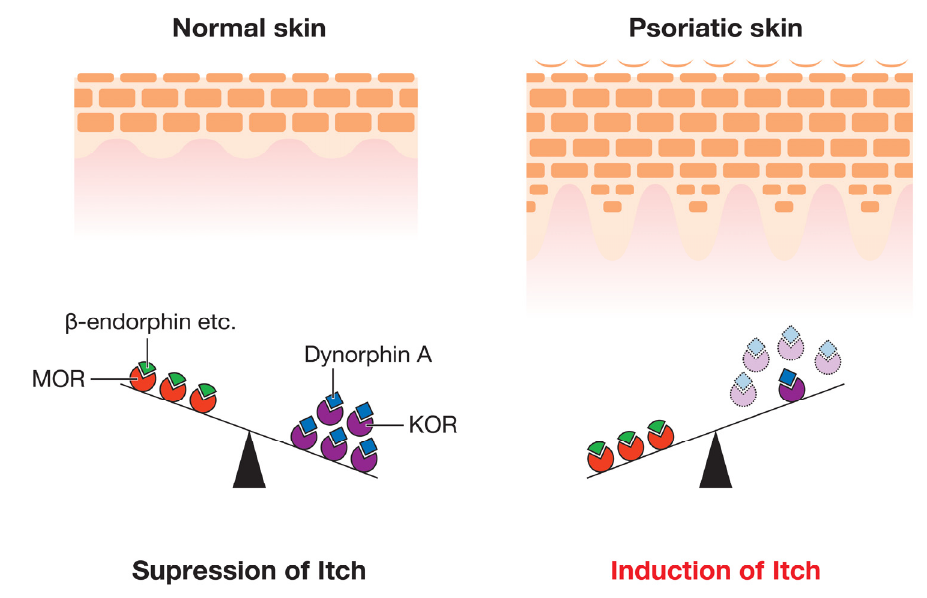
Figure 2. Changes in the expression of opioid receptors and their ligands in psoriatic lesions. In normal skin ( left ), itch is constitutively suppressed when KOR and its ligand dynorphin A, which attenuate itch, are strongly expressed and MOR and its ligand β -endorphin, which are involved in the induction of itch, are also expressed. However, in the lesional skin of patients with psoriasis ( right ), although the expression of MOR and β -endorphin remain unchanged, that of KOR and dynorphin A decreases. This imbalance between KOR and MOR controls itch in psoriasis. (KOR; κ -opioid receptor, MOR; µ -opioid receptor)